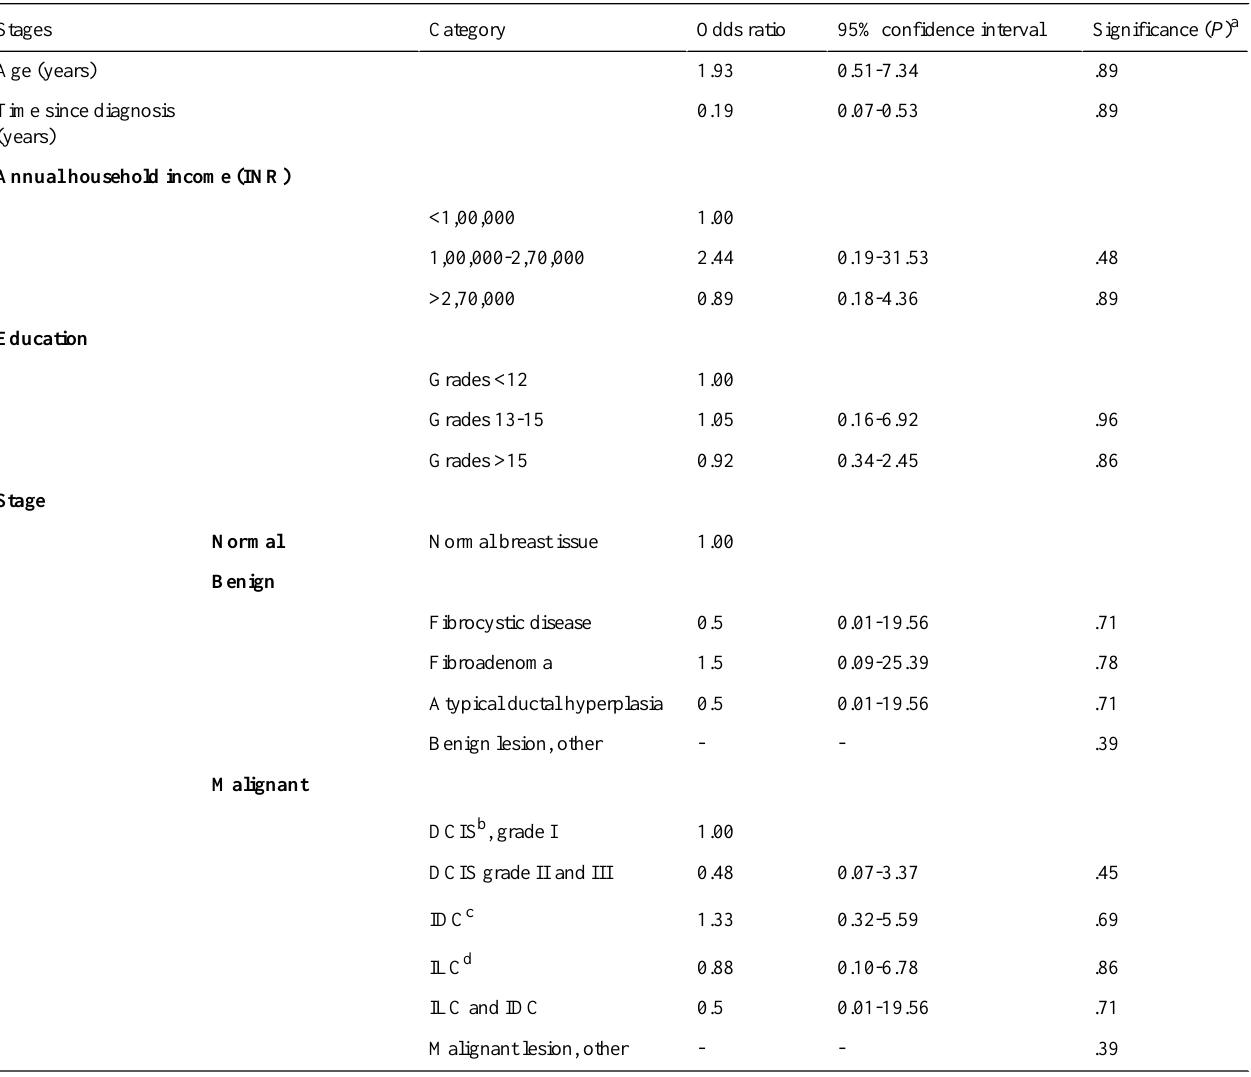
Table 4. Predictors of CIMIDx use of 150 women with breast